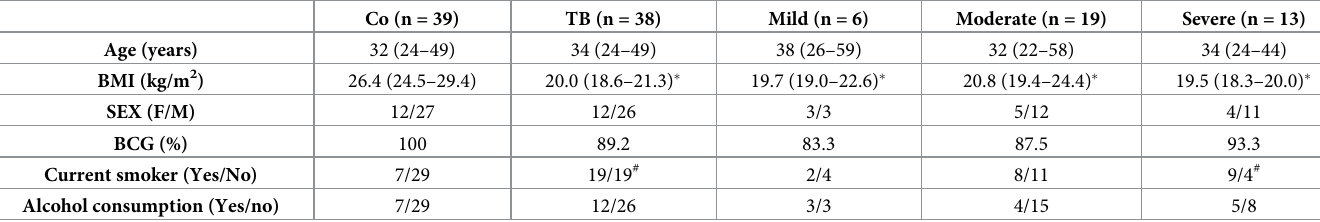
Table 2. Characteristics of control subjects and TB